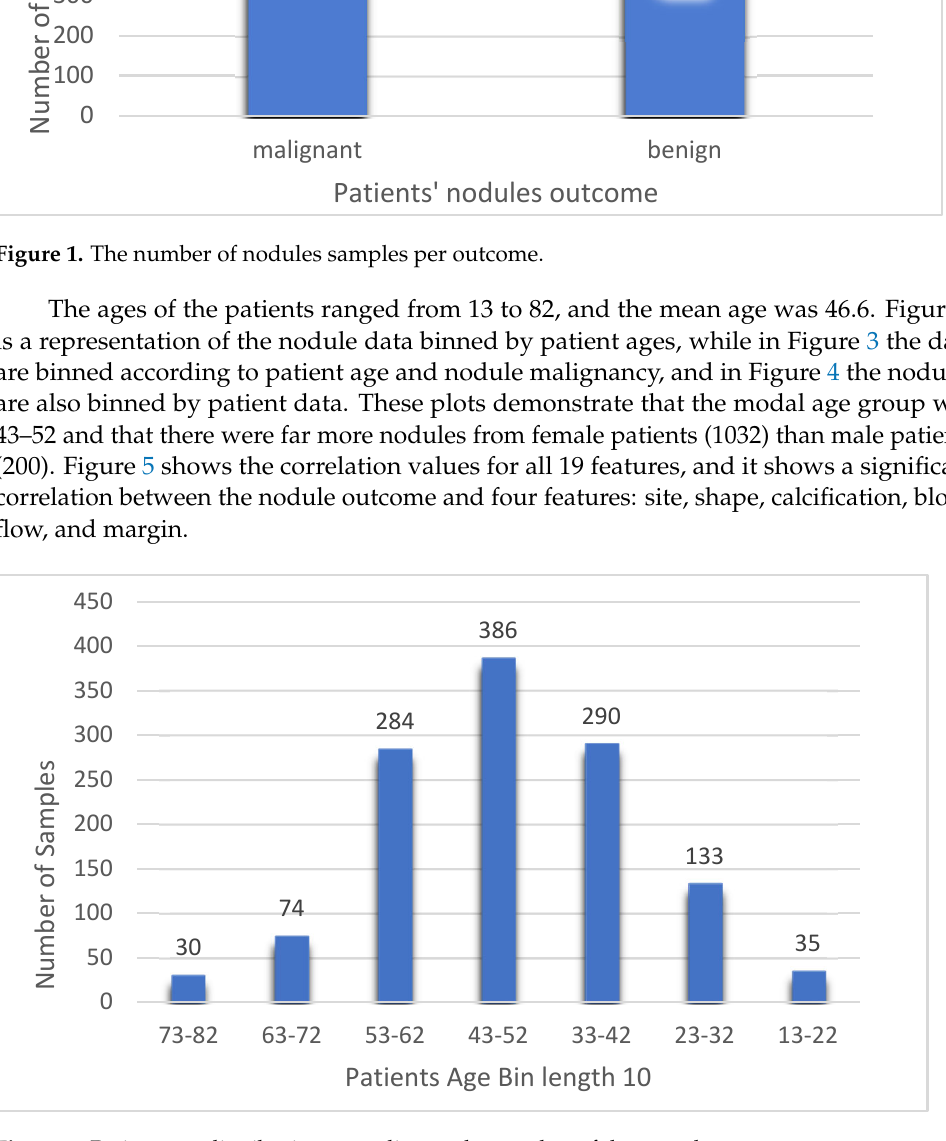
Figure 2. Patient age distribution according to the number of the samples.